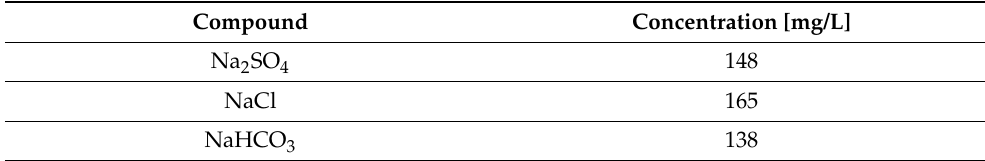
Table 4. Chemical composition of the corrosive water solution.